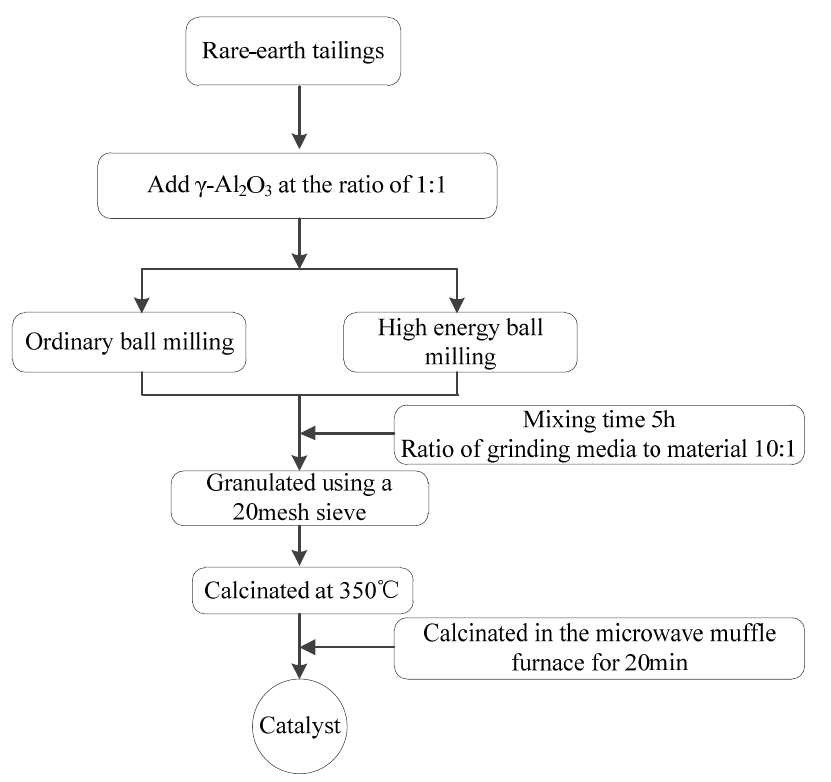
Figure 8. Flow chart of catalyst preparation.